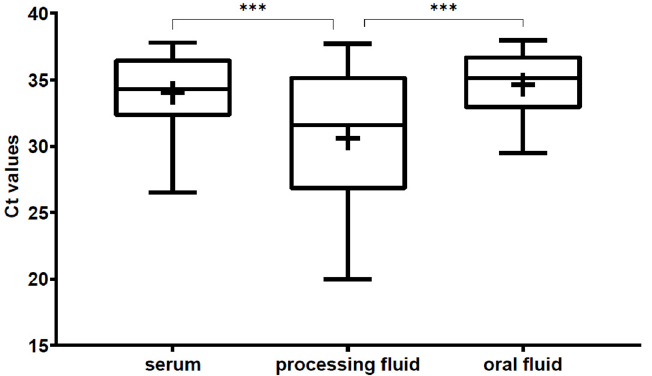
Figure 2. Boxplots representing the Ct values of the PCV3-positive samples of the three different sample types. The whiskers show the minimum and the maximum, and the “+” signs represent the average. The horizontal lines of the box show the first quartile, the median and the third quartile. The statistical comparison of the Ct values was performed using the Mann–Whitney test. The asterisks above the boxes represent the statistically significant differences (***: p <